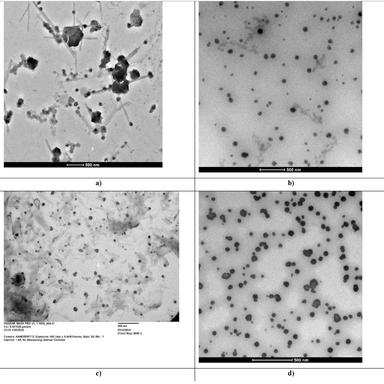
TEM micrographs of pristine form of PPPs: a) CS; b) EC; c) OD; d) WP.